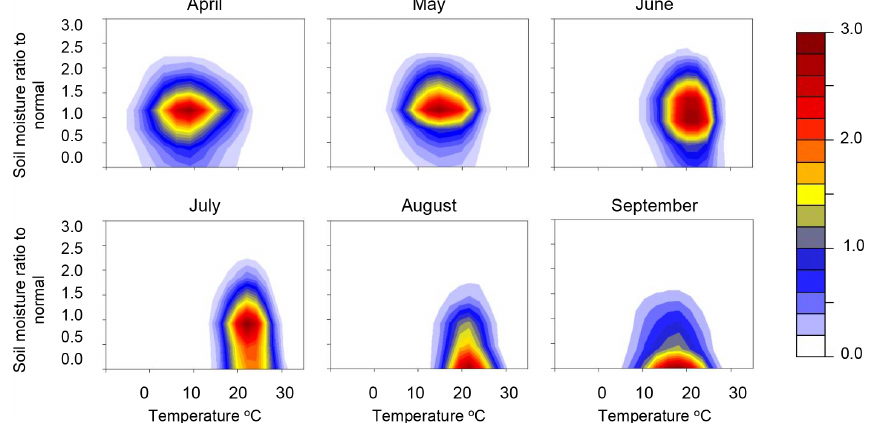
Figure 4. The bivariate density of heat and soil moisture for 1981–2015 for all the grid cells in the US Corn Belt. The precipitation is aggregated from PRISM, and soil moisture is aggregated from WBM based on 2.5arcmin grid